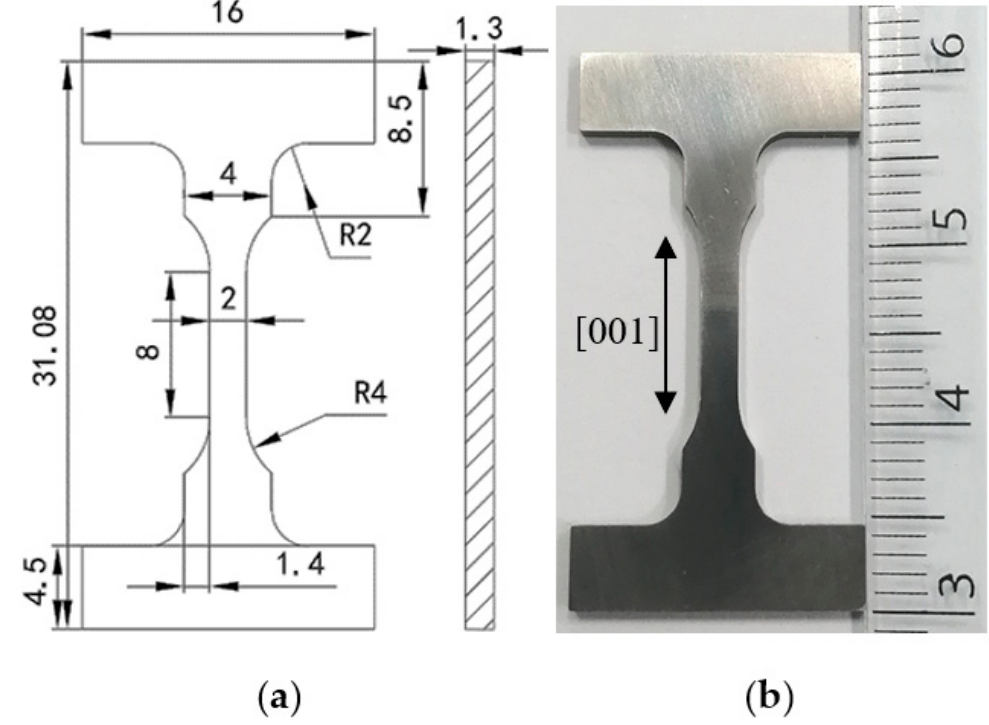
Figure 2. I-shaped test piece. ( a ) Geometric size diagram, ( b ) physical diagram.